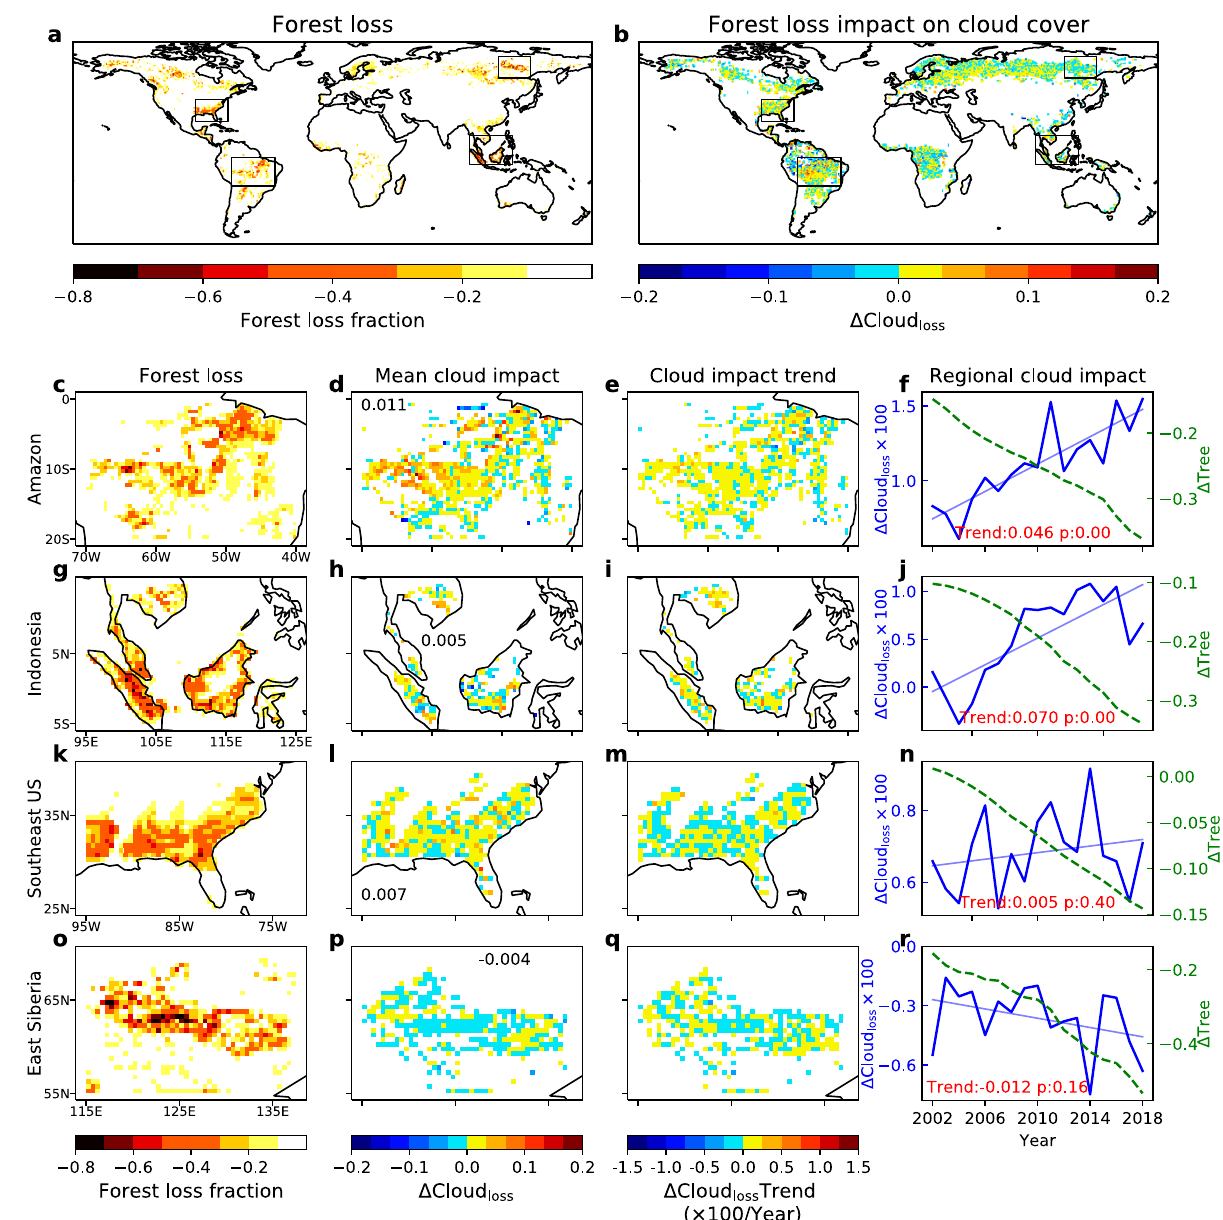
Fig. 5 Impacts of forest loss on JJA cloud cover based on MODIS data from 2002 to 2018. a The accumulated forest loss fraction from 2001 to 2018. b The actual cloud impact of forest loss ( Δ Cloud loss ), de fi ned as the mean cloud difference between forest loss location and nearby unchanged forests from 2002 to 2018. Four hotspot regions that experienced intensive forest loss are highlighted in panels c to r , showing their forest loss fractions, mean Δ Cloud Δ Cloud loss during the study period, and regional and temporal trends of loss between 2002 and 2018 (column-wise). The cloud impacts in forest loss hotspot regions are estimated from grid boxes with tree cover loss fraction >0.05. The green dashed line in the last column ( f , j , n , r ) shows the annual tree cover difference between forest loss location and nearby unchanged forests ( Δ Tree); the solid blue line shows the temporal trends of Δ Cloud loss (unit: %/year); and the thin blue line and text show the linear fi tted trend and its p